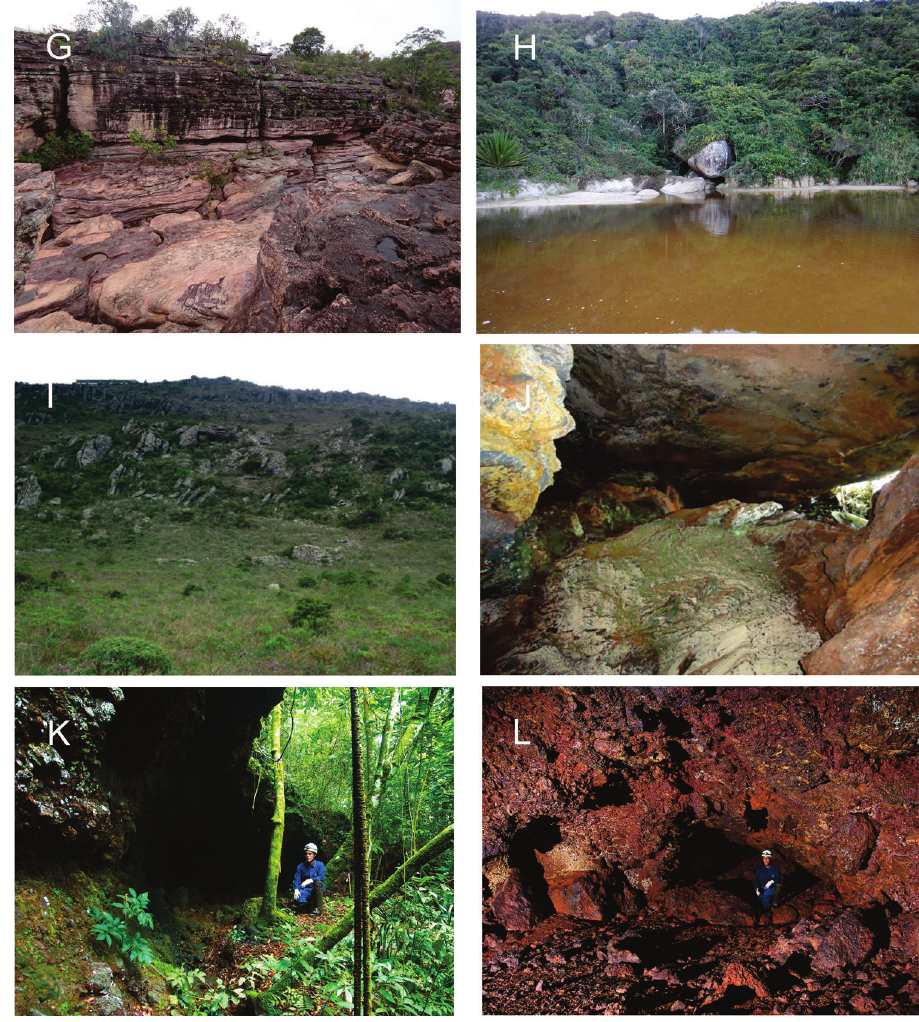
Figure 4. Continued. G Sandstone outcrop from Igatu, Chapada Diamantina, Bahia state (J.E. Gallão) H Granite outcrop and Atlantic Rainforest from Florianópolis, Santa Catarina state (J.E. Gallão) I Iron ore outcrop with Cerrado from Caeté, Minas Gerais state (M.E. Bichuette) J Iron ore cave from Caeté, Minas Gerais state (M.E. Bichuette) K, L Iron ore caves and Canga vegetation from Canaã dos Carajás, Pará state (A.